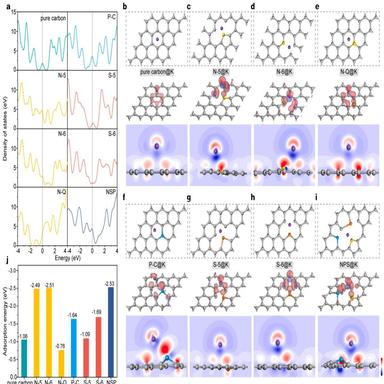
Theoretical investigation. a) DOS diagrams of different carbon substrates. Top views of K atom adsorbed in b) pure carbon, c) N-5 doped carbon, d) N-6 doped carbon, e) N-Q doped carbon, f) P-doped carbon, g) S-5 doped carbon, h) S-6 doped carbon, and i) N/P/S-tridoped carbon, and the corresponding charge density differences after K+ adsorption. The grey, purple, yellow, blue, and orange balls represent carbon, potassium, nitrogen, phosphorus, and sulfur atoms, respectively. Blue and red areas represent decr